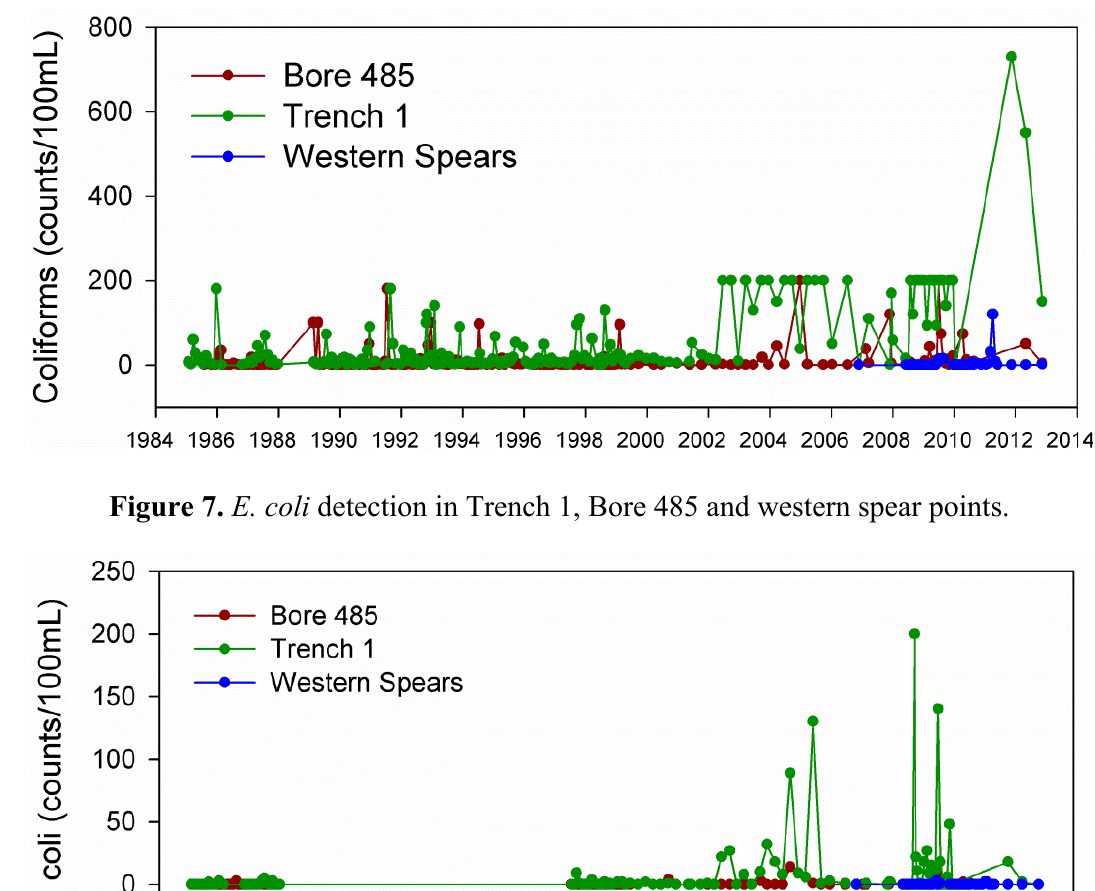
Figure 6. Coliform detection in Trench 1, Bore 485 and western spear points.